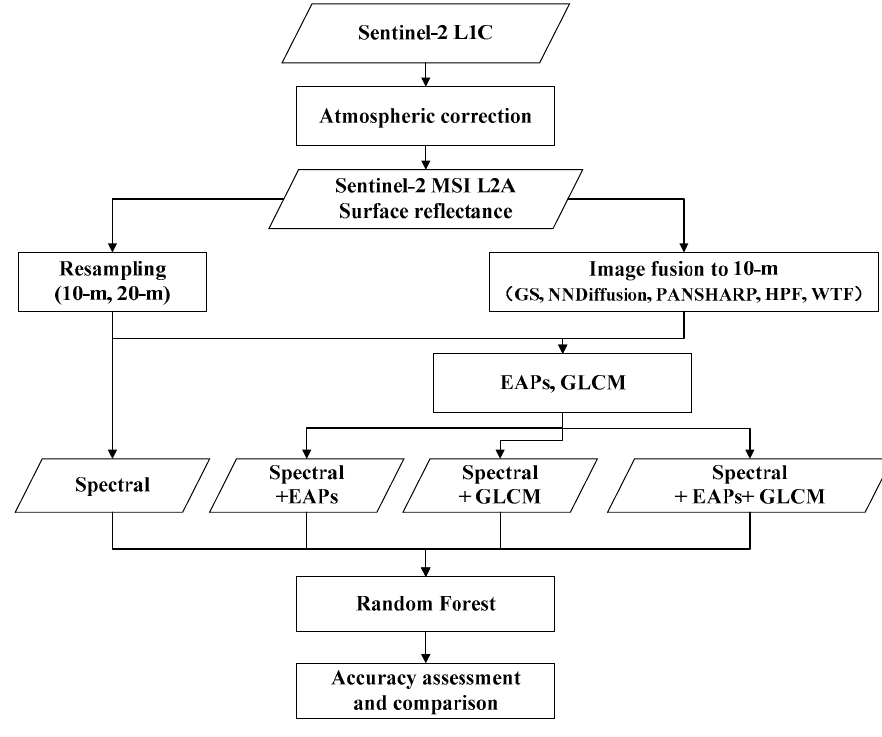
Figure 2. Technical flow chart.